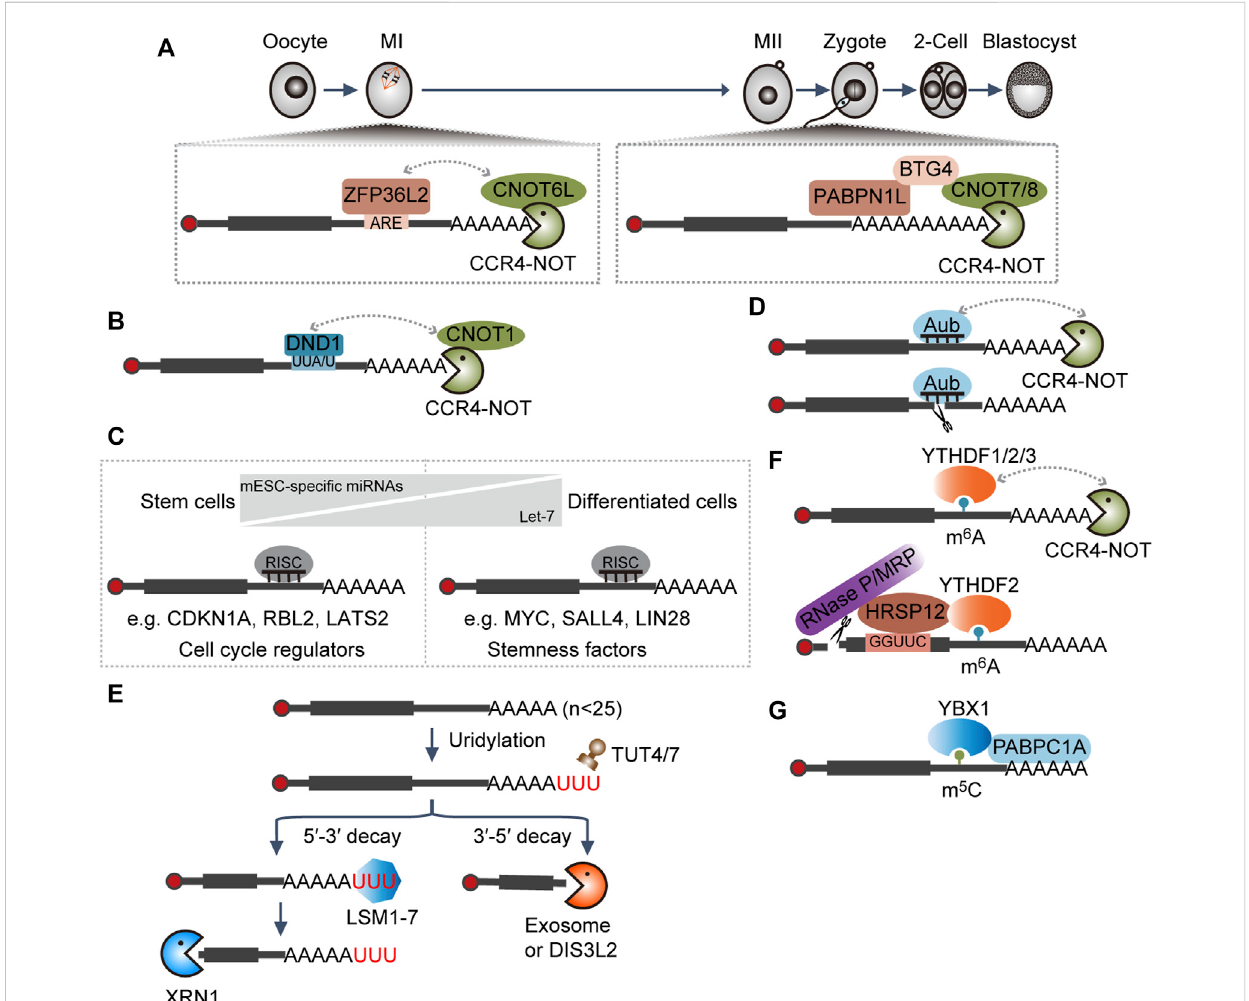
FIGURE 2 Interplay between RNAs and RNA-binding proteins (RBPs) dictates RNA decay. (A,B) RBP-mediated RNA degradation. ARE, AU-rich element; CCR4 – NOT, RNA deadenylation complex. (C) miRNA-mediated RNA degradation. miRNA, microRNA; RISC, RNA-induced silencing complex; mESC- speci fi c miRNAs, miRNAs speci fi cally expressed in mouse embryonic stem cells: miR-291a-3p, miR-291b-3p, miR-294, miR-295, and miR-302. (D) piRNA-mediated RNA degradation. piRNA, Piwi-interacting RNA; Aubergine (Aub), the cytoplasmic Piwi proteins in Drosophila. (E) RNA uridylation- mediatedRNAdegradation.TUT4/7,RNAterminaluridylyltransferases;LSM1-7,acomplexthatespeciallyrecognizesthesubstratewith3 ′ terminaloligoA tailandfunctionsinfacilitatingRNAdecapping;DIS3L2,RNA3 ′ -to-5 ′ exonucleasethatespeciallyfunctionsinclearingRNAswith3 ′ U-tail;XRN1,5 ′ -to-3 ′ RNA exonuclease; exosome, 3 ′ -to-5 ′ RNA exonuclease complex. (F) m 6 A-modi fi cation-mediated RNA degradation. m 6 A, N6-methyladenosine; RNase P/MRP, a complex with endonucleolytic activity. (G) m 5 C-modi fi cation-mediated RNA stabilization. m 5 C,